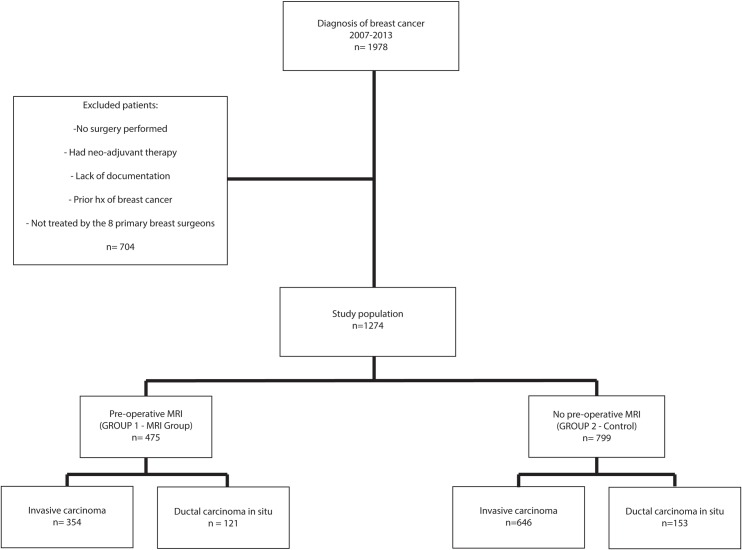
Patient Flow Chart.